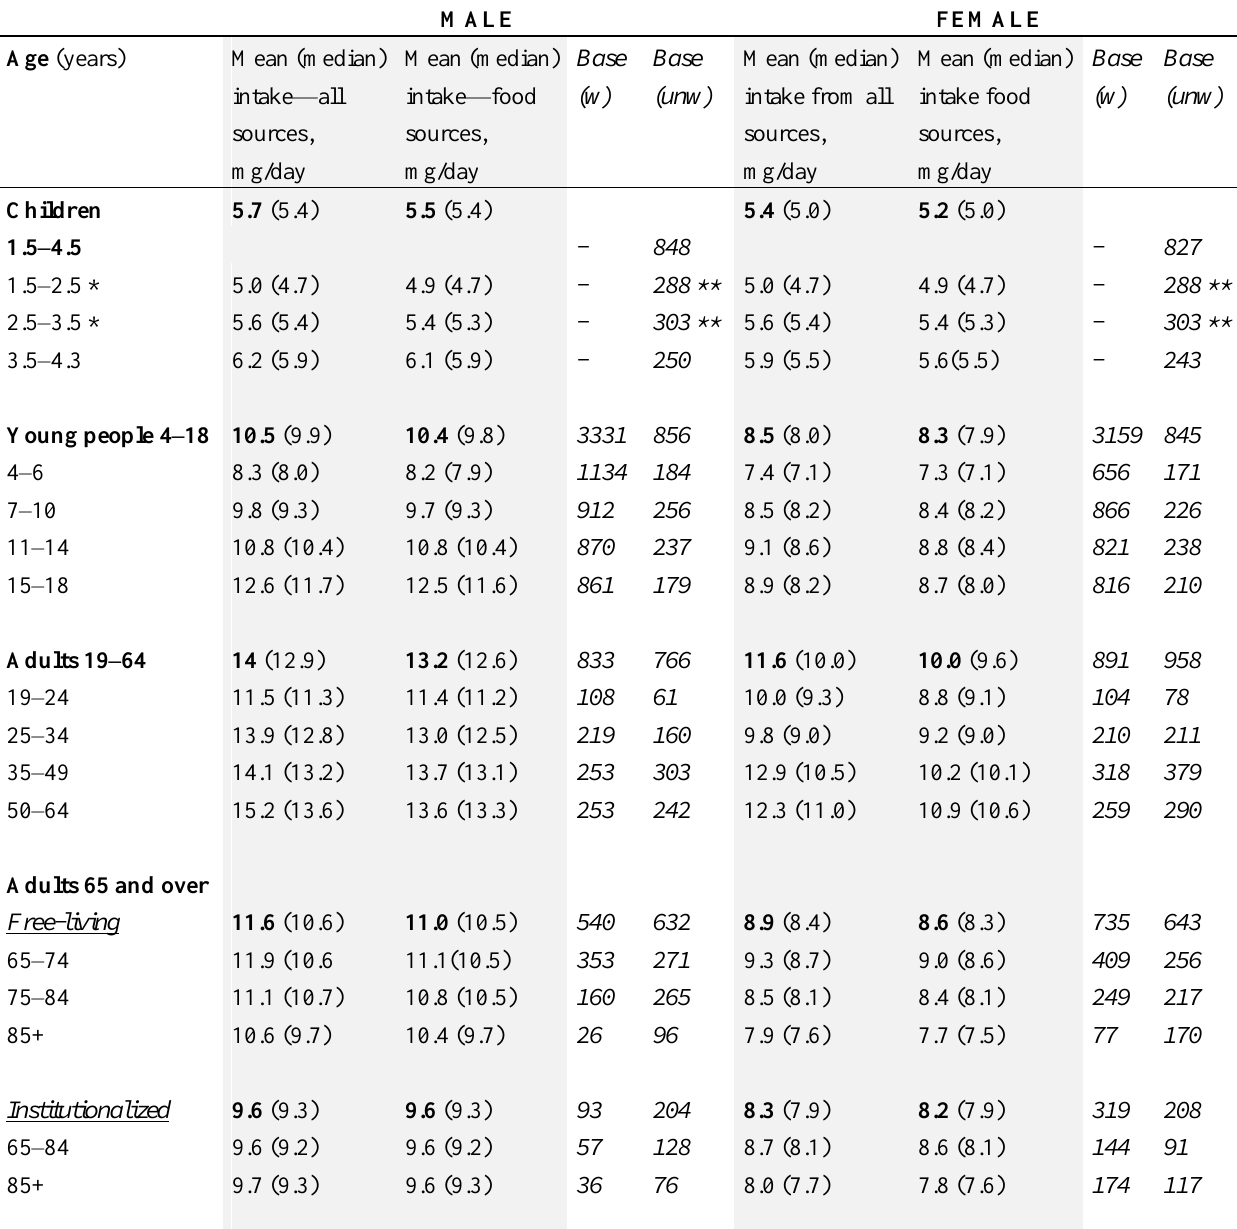
Table 9. NDNS—Total mean (median) iron intake from all sources and food sources.